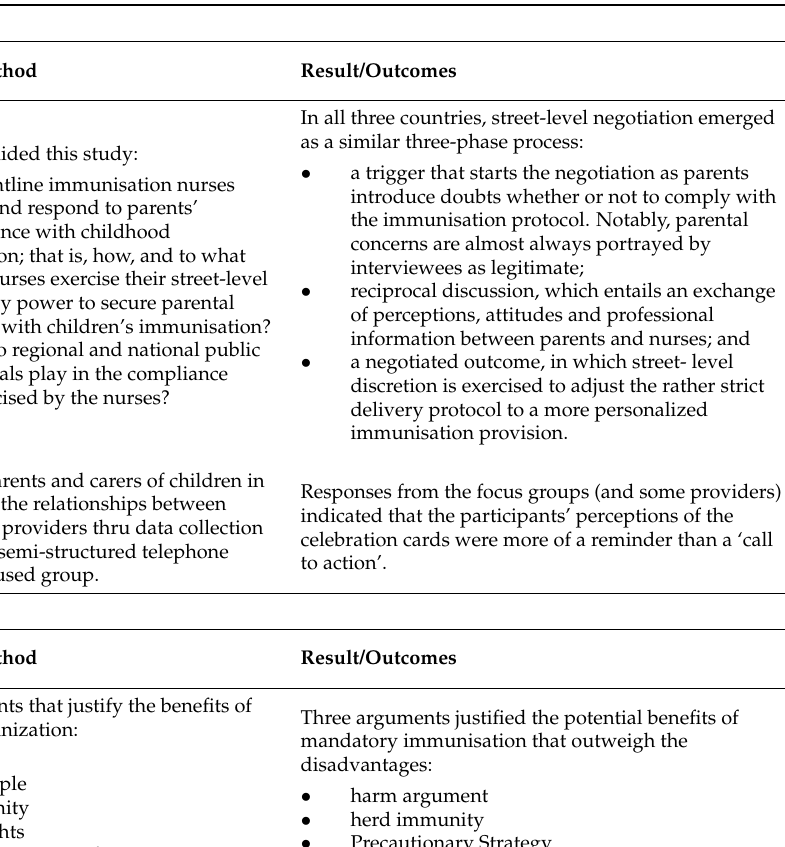
Table 3. Study characteristics included articles influencing vaccine